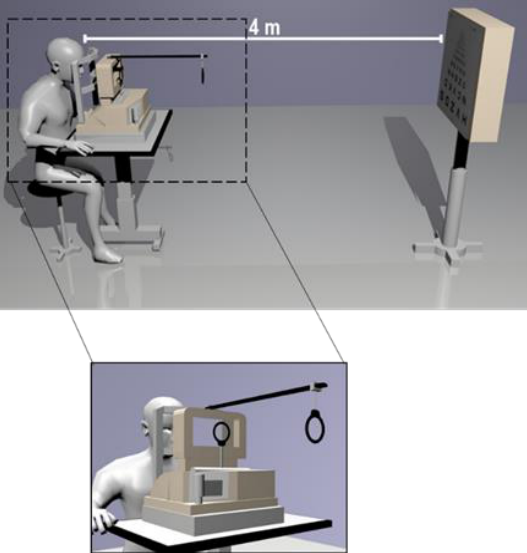
Figure 1. Representation of the monocular Badal system with the ETDRS chart placed at a 4 m distance. A close-up shows the auxiliary and movable lenses in more detail.